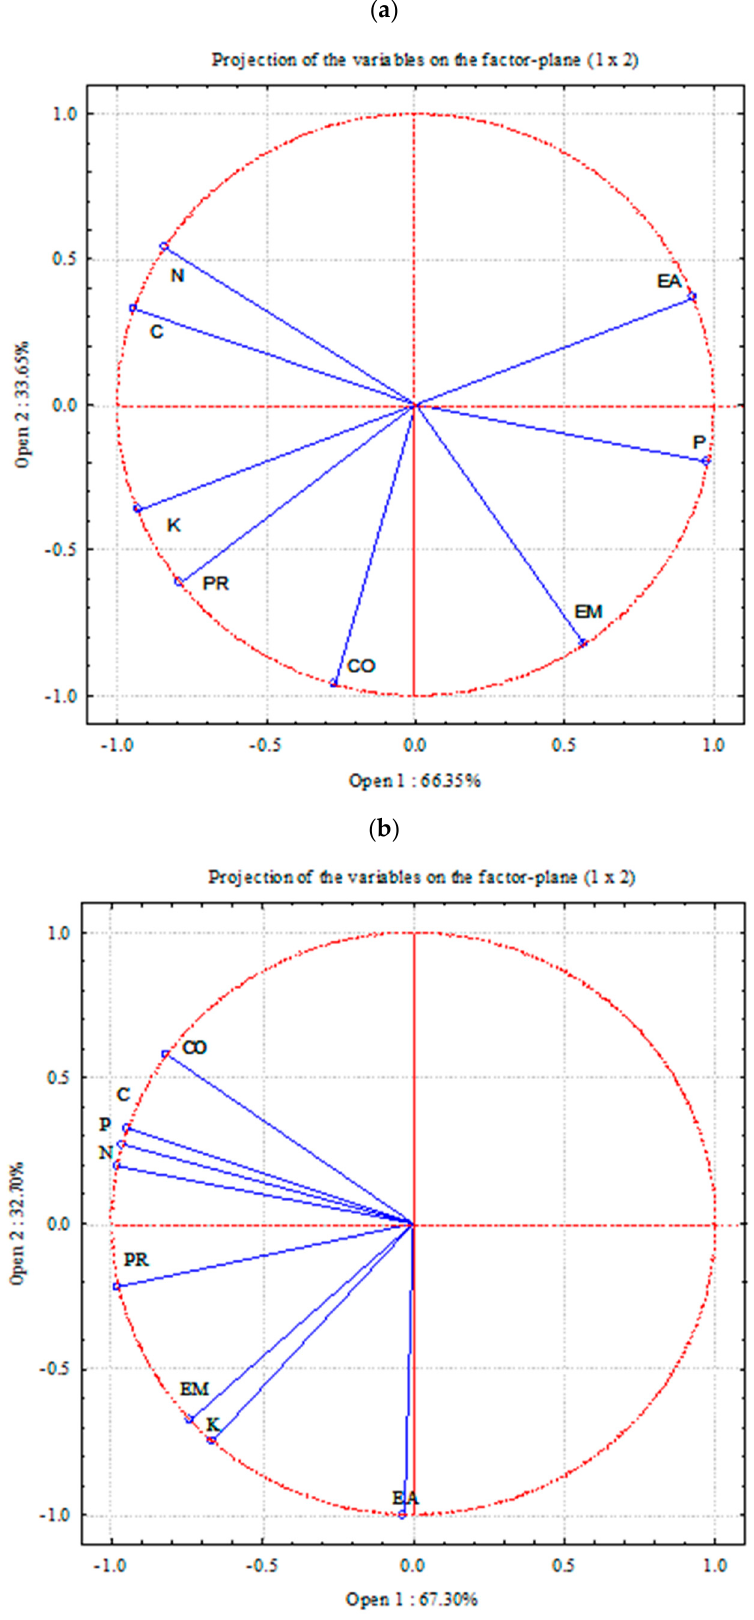
Figure 5. Relationships between different parameters depending on the crop rotations used in 2016 (Figure ( a )) and 2017 (Figure ( b )). Note: N, total nitrogen; C, organic carbon; K, available potassium; P, available phosphorus; CO, soil CO 2 emission; EA, amount of earthworms; EM, mass of earthworms; PR,